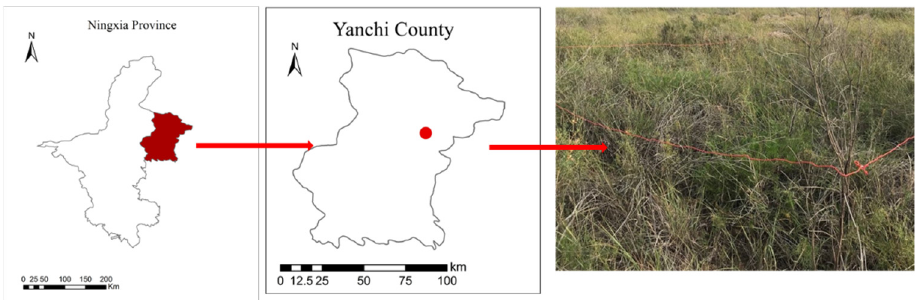
Figure 1. Map of the study site and its dominant plant cover.